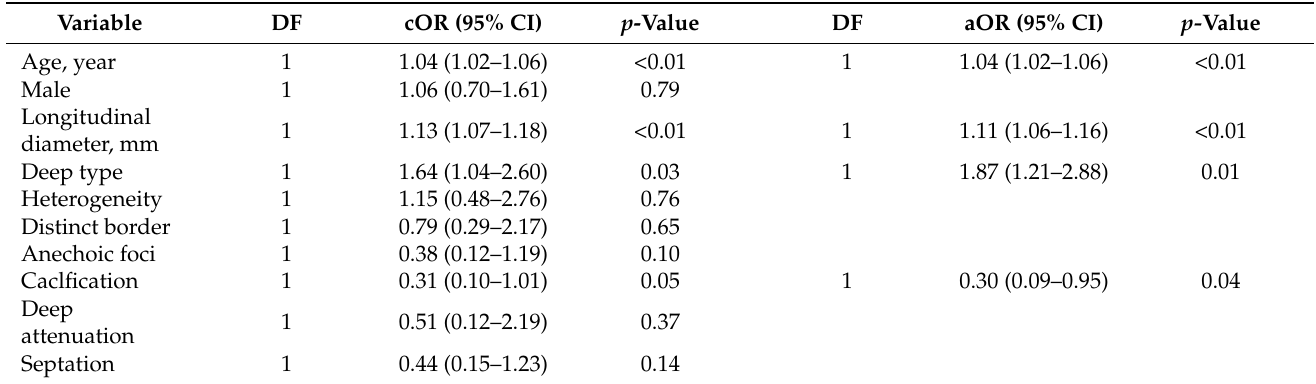
Table 3. Cox regression analysis of endoscopic ultrasonographic findings to predict an increase in the size of upper gastrointestinal subepithelial